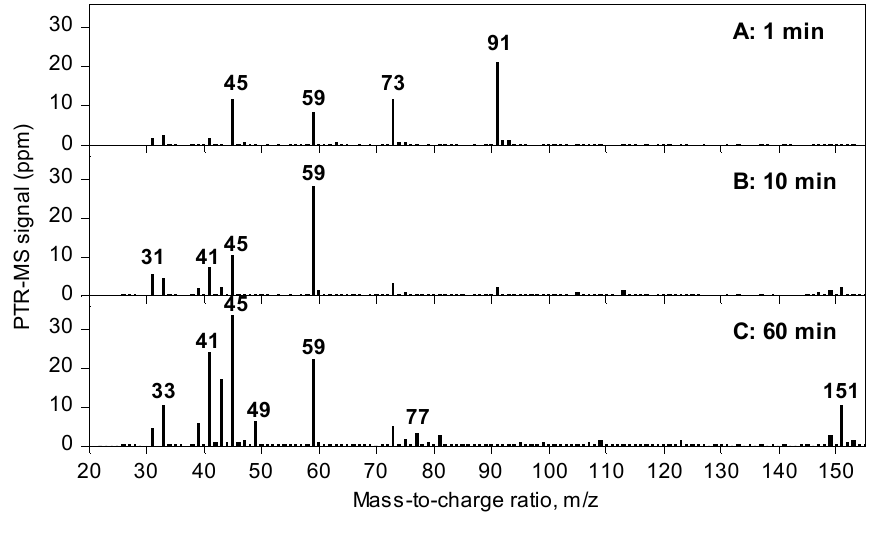
Figure 4. PTR-MS spectra of freshly cut onion volatiles ( A ) 1 min; ( B ) 10 min and ( C ) 60 min after cutting. Data are presented as the averages of three consecutive scans and are corrected for the dilution factor. Water clusters, oxygen (O 2+ ), and isotopic masses of these are not